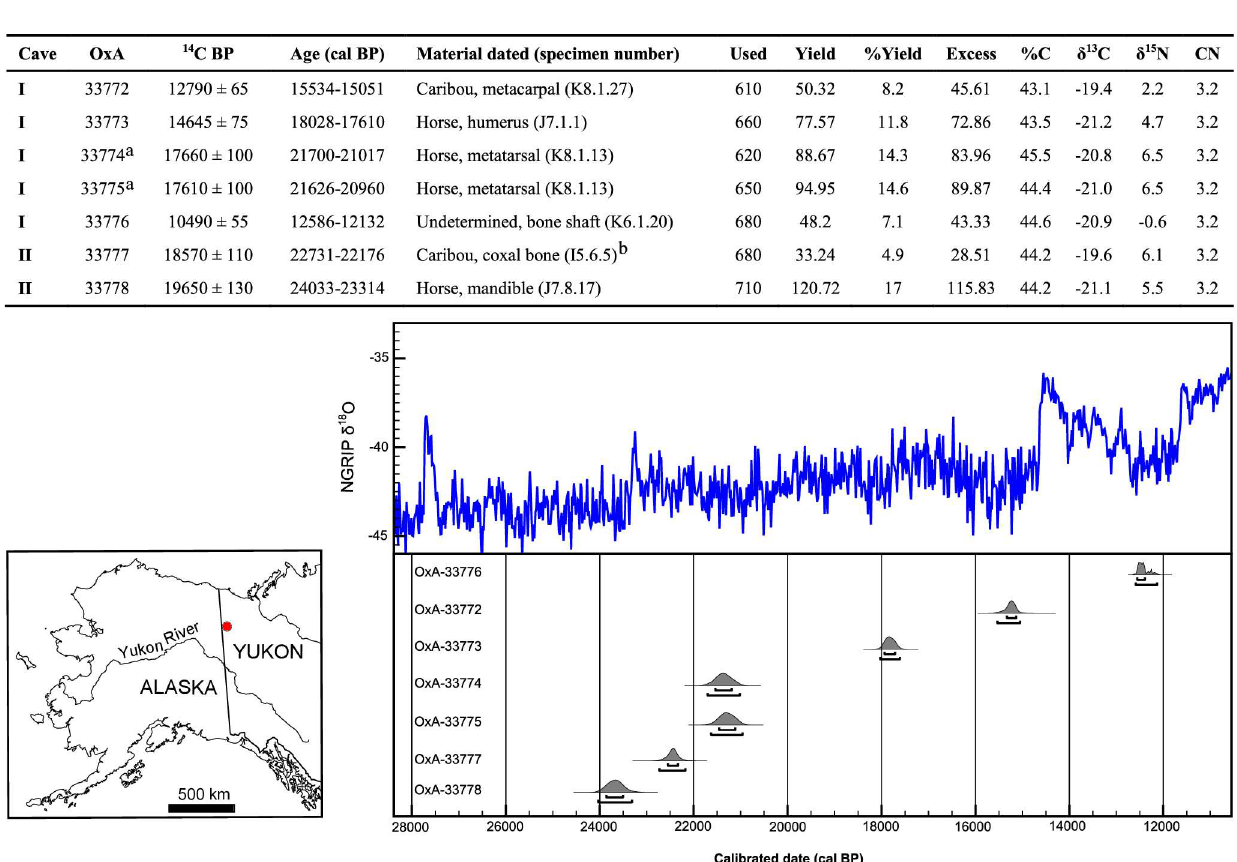
Fig 3. New radiocarbon determinations obtained on bone from Bluefish CavesI and II. The red dot on the map indicatesthe location of the site. Conventional radiocarbonages are expressedin 14 C BP [70], values are ± one standarderror [71]. Calibrations (cal BP) were made using OxCal 4.2 [67] and the INTCAL113 calibrationcurve [68]. ‘Used’ representsthe amount of bone powderpretreatedin milligrams. ‘Yield’ representsthe weight of collagenor ultrafilteredcollagenin milligrams. ‘%Yield’is the percent yield of extracted collagenas a function of the starting weight of the bone analyzed.‘%C’ is the carbon present in the combusted collagenand averages40 ± 2% in the ORAU. Stable isotope ratios are expressedin ‰ relativeto vPDB [72] with a mass spectrometric precisionof ± 0.2 ‰ for C and ± 0.3 ‰ for N. ‘CN’ is the atomic ratio of C to N and is acceptable if it rangesbetween2.9–3.5. a Denoteduplicatemeasurements from the start of the pretreatmentchemistry. b Specimen also identifiedin previousarticle